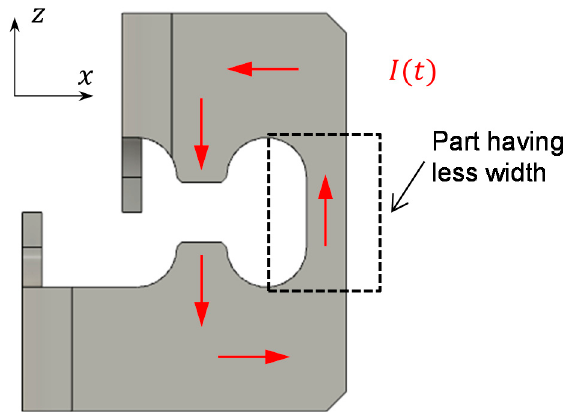
Figure 13. O-Shape rectangular cross-section